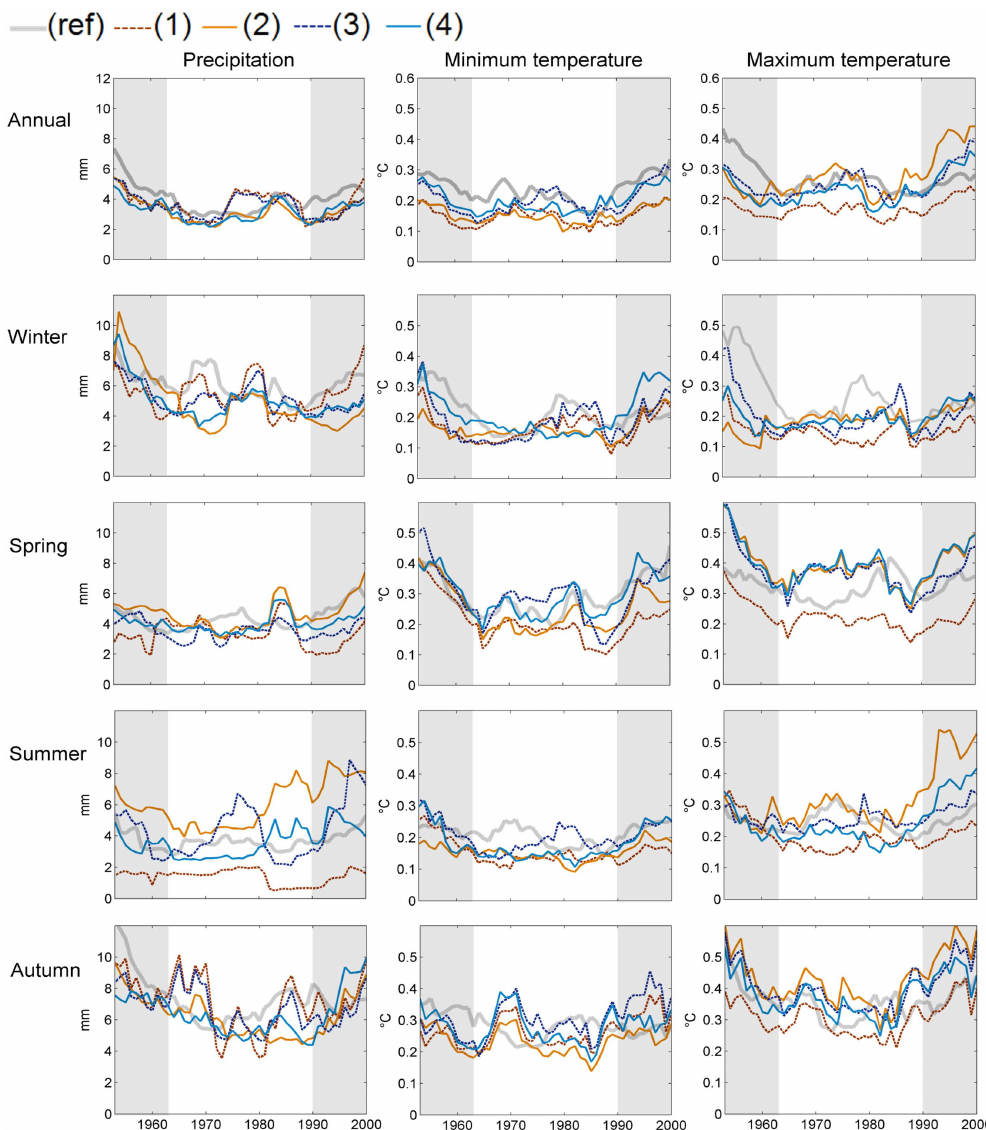
Fig. 7. Annual and seasonal standard deviation of quantiles between the quantiles computed on a 21yr window and on the whole period. Precipitation, minimum and maximum temperature analysis for land observations (ref), GCM (1), GCM-DD (2), GCM-SD (3) and GCM- DD-SD (4). Grey rectangles represent values computed with less than